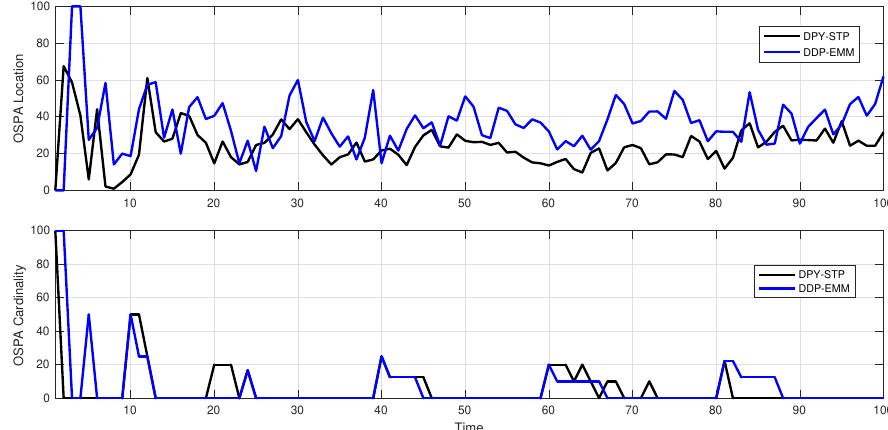
Figure 11. OSPA comparison between DPY-STP (black) and DDP-STP